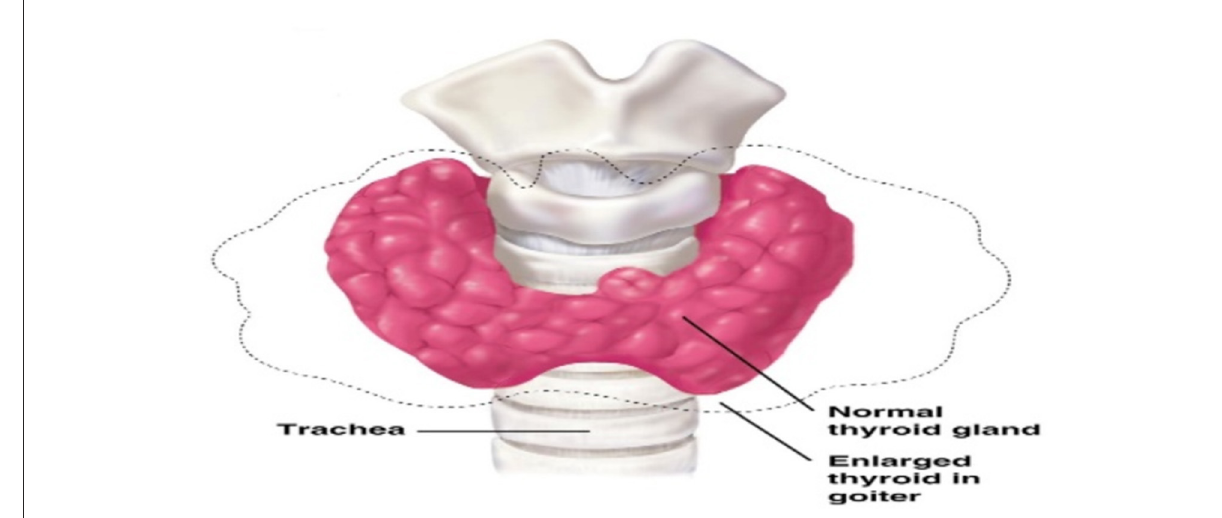
FIGURE2 Goiter illustration by the Centre for Disease Control (CDC),